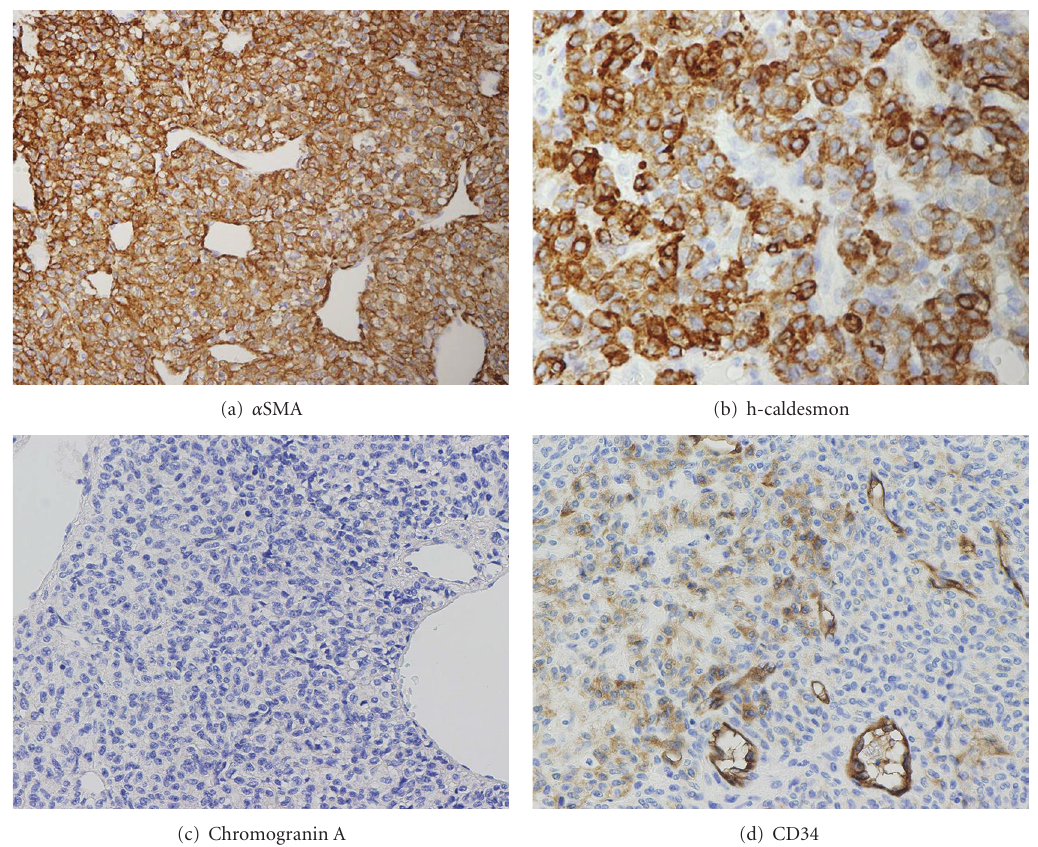
Figure 3: (a–c) Immunostaining revealing that the tumor cells showed a di ff use positive expression of α SMA and h-caldesmon at the cell membrane and cytoplasm but were negative for chromogranin A. (d) CD34 was found to be only focally positive in perivascular tumor cells.